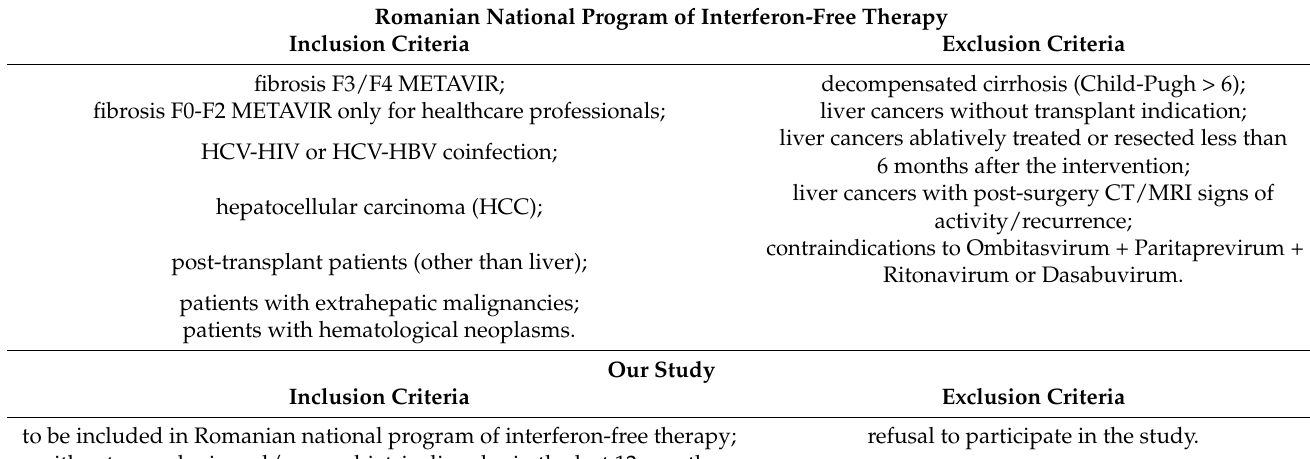
Table 1. Inclusion and exclusion criteria for the Romanian national program of interferon-free therapy and our